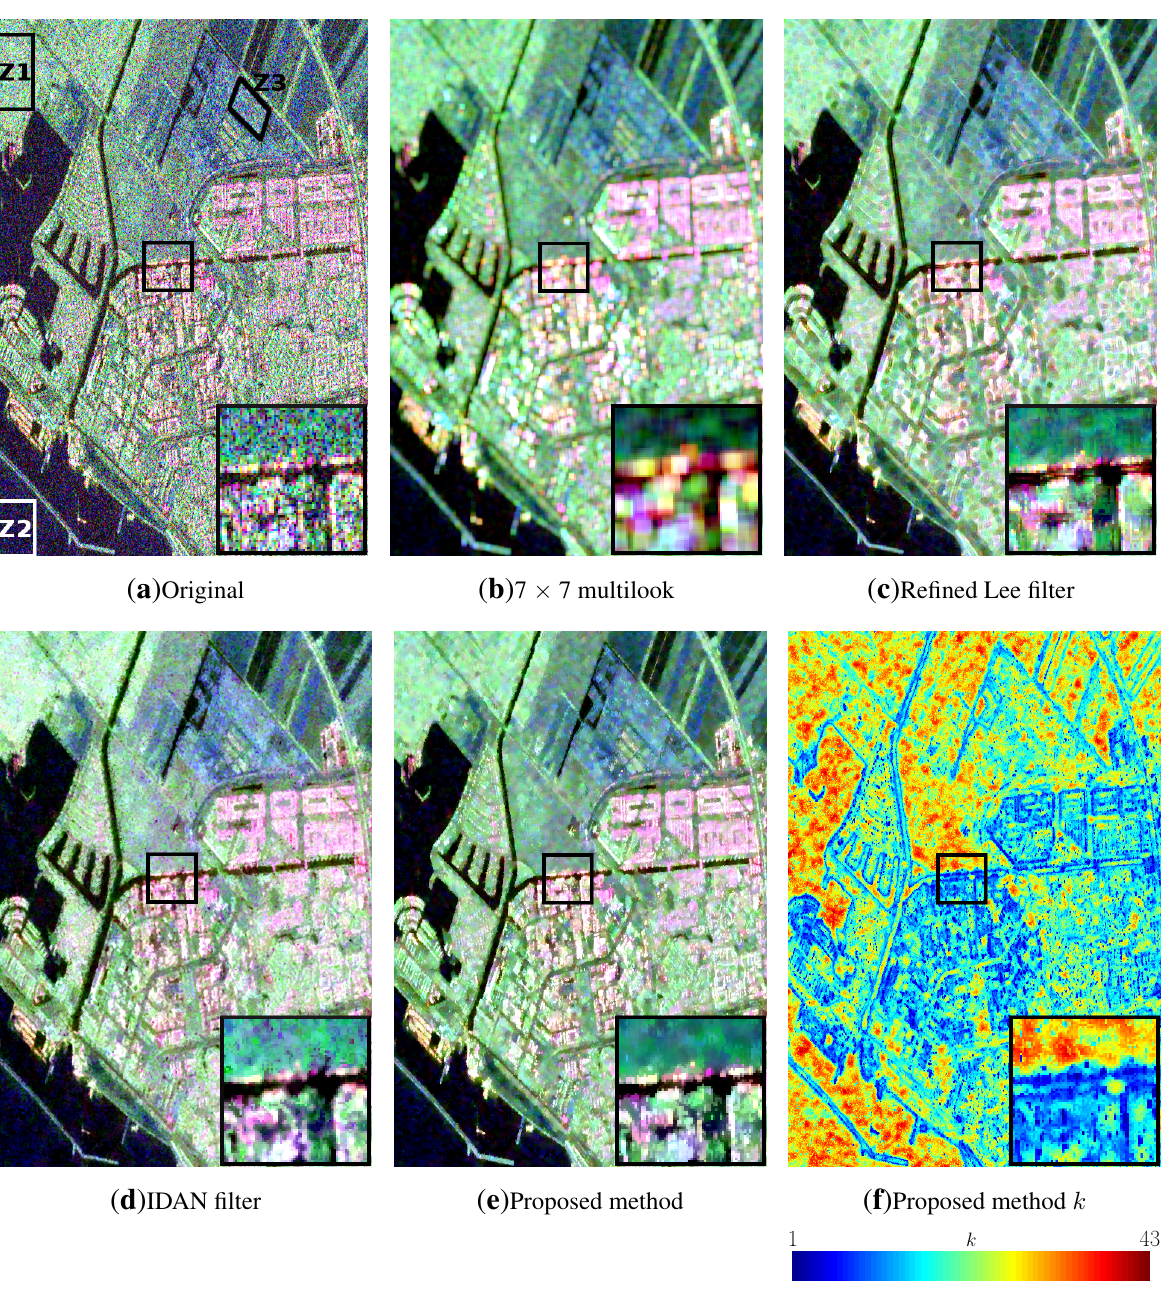
Figure 4. Pauli RGB ( | HH − V V | , | HV + V H | , | HH + V V | are assigned to